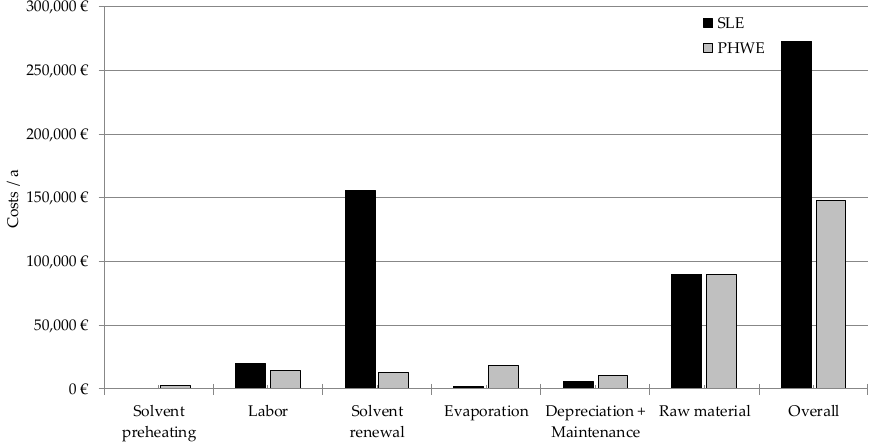
Figure 15. Annual Cost of Goods for hawthorn, Comparison SLE and PHWE [50].